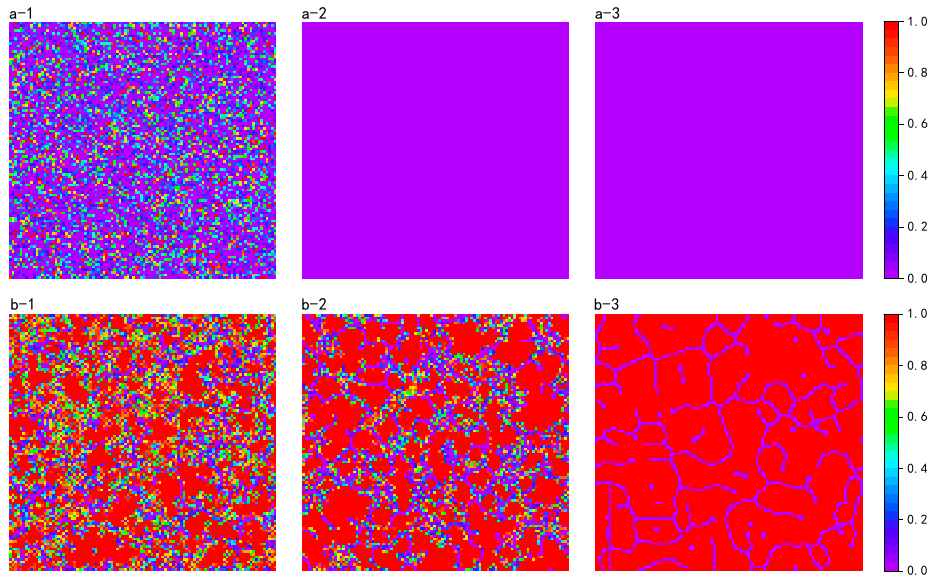
Figure 8. Comparisons of strategy space distributions for different combinations of r and α : ( a ) at r = 2.0; ( b ) at r = 4.0. ( 1 ) ω = 0.8, α = infinite; ( 2 ) ω = 0.8, α = 4; ( 3 ) ω = 0.8, α = 1. Snapshots were obtained at time-step 50,000. The color encoding, as depicted at the right of each chart, indicates the values of 𝐼 (cid:3036) for each individual.